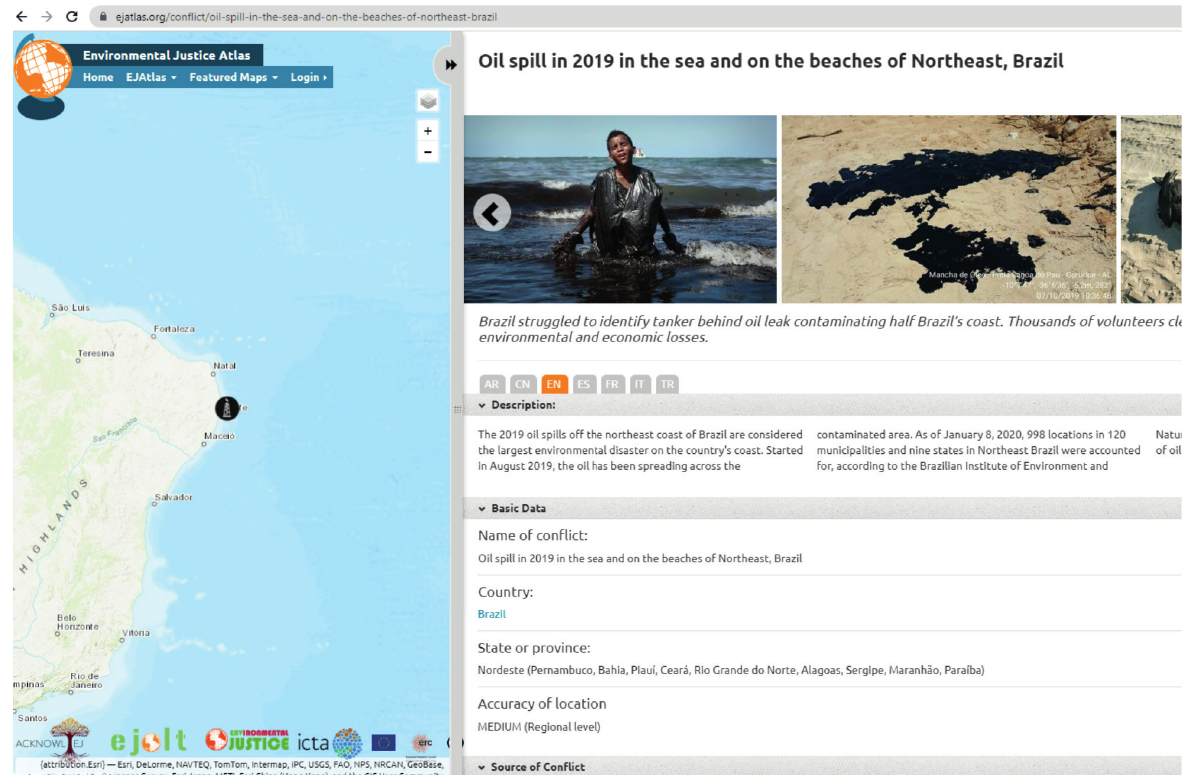
Figure 1. Image of the oil spill mapping page on the coast of northeastern Brazil on the EJAtlas platform. On the left, the virtual map, showing the area where the confl ict is located, the symbol (tower in a black circle) used is what characterizes that the confl ict is associated with fossil fuels. On the right, the confl ict title and brief description can be seen. On the right side, the cover image of the publication was chosen because it represents the exposure to oil, including of children and adolescents. Available on https://ejatlas.org/confl ict/oil-spill-in- the-sea-and-on-the-beaches-of-northeast-brazil. Source: EJAtlas